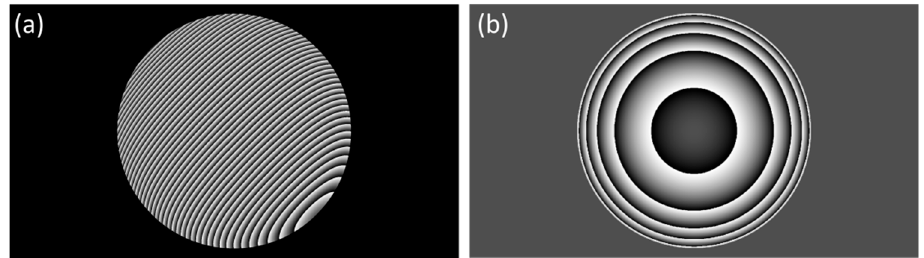
Figure 2. Phase shifting holograms for SA correction visualized as greyscale images. The hologram displayed on the surface of SLM ( a ) included a grating and a spherical aberration ( b ) part (here calculated for z m = 70 μ m).